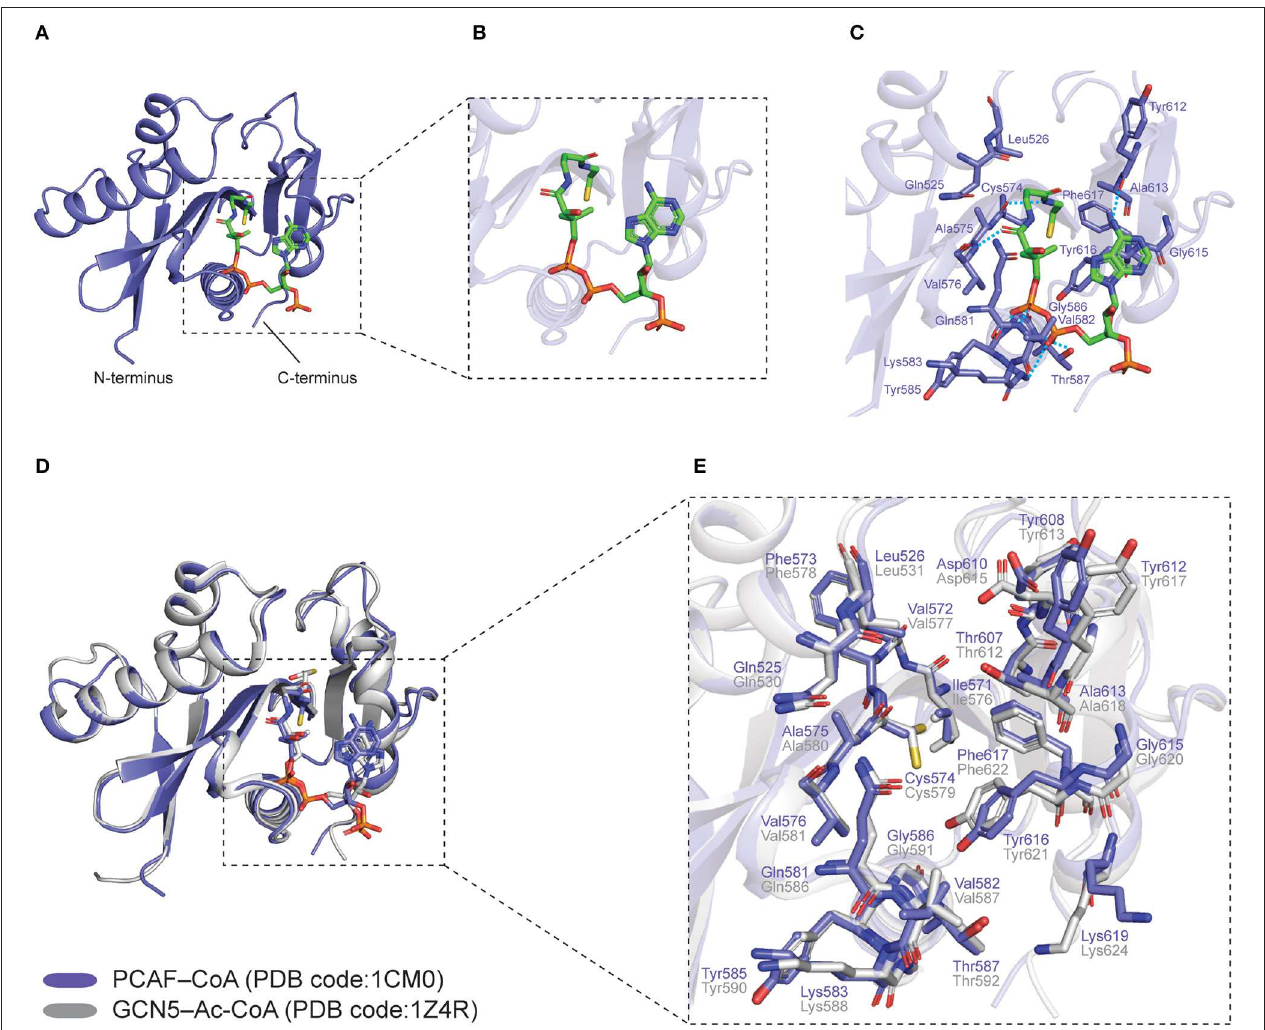
FIGURE 2 | Co-crystal structures of human PCAF–CoA (PDB code: 1CM0 ) and GCN5–Ac-CoA (PDB code: 1Z4R ) HAT domains. PCAF–CoA is shown in purple, while GCN5–Ac-CoA is shown in gray. (A) Structure of PCAF–CoA comprising a central core composed of a β -sheet flanked by a parallel α -helix on one side, as well as α and β segments surrounding it. CoA is shown as green sticks. (B) Magnified view of the CoA molecule in a bent conformation. (C) Interaction between PCAF residues and CoA at the catalytic site. Hydrogen bonds are shown as blue dashed lines. (D) Superimposition of PCAF–CoA and GCN5–Ac-CoA overall structures. CoA and Ac-CoA are shown as sticks in the same color as their corresponding HAT proteins. (E) Superimposition of PCAF–CoA and GCN5–Ac-CoA residues at the catalytic site. CoA and Ac-CoA have been removed for clarity. All structural figures were produced using PyMOL (The PyMOL Molecular Graphics System, Version 2.3.2 Schrödinger, LLC)